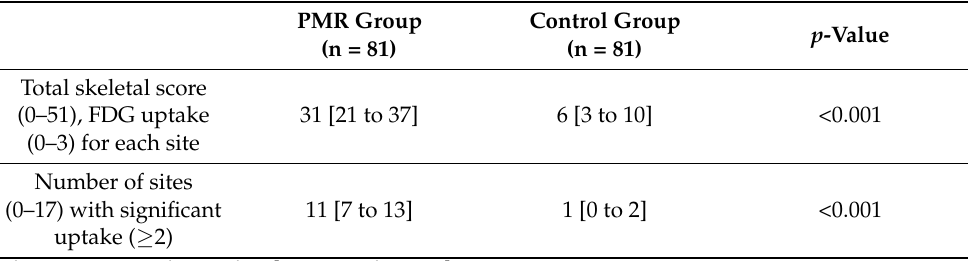
Table 2. FDG-PET/CT results in patients and controls.